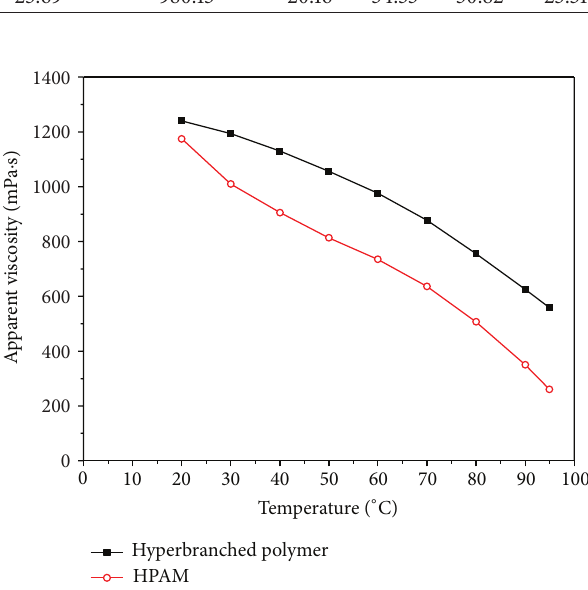
Figure 7: 𝐾𝐶/𝑅 VV (𝑞) versus 𝑞 2 for the hyperbranched polymer and HPAM.